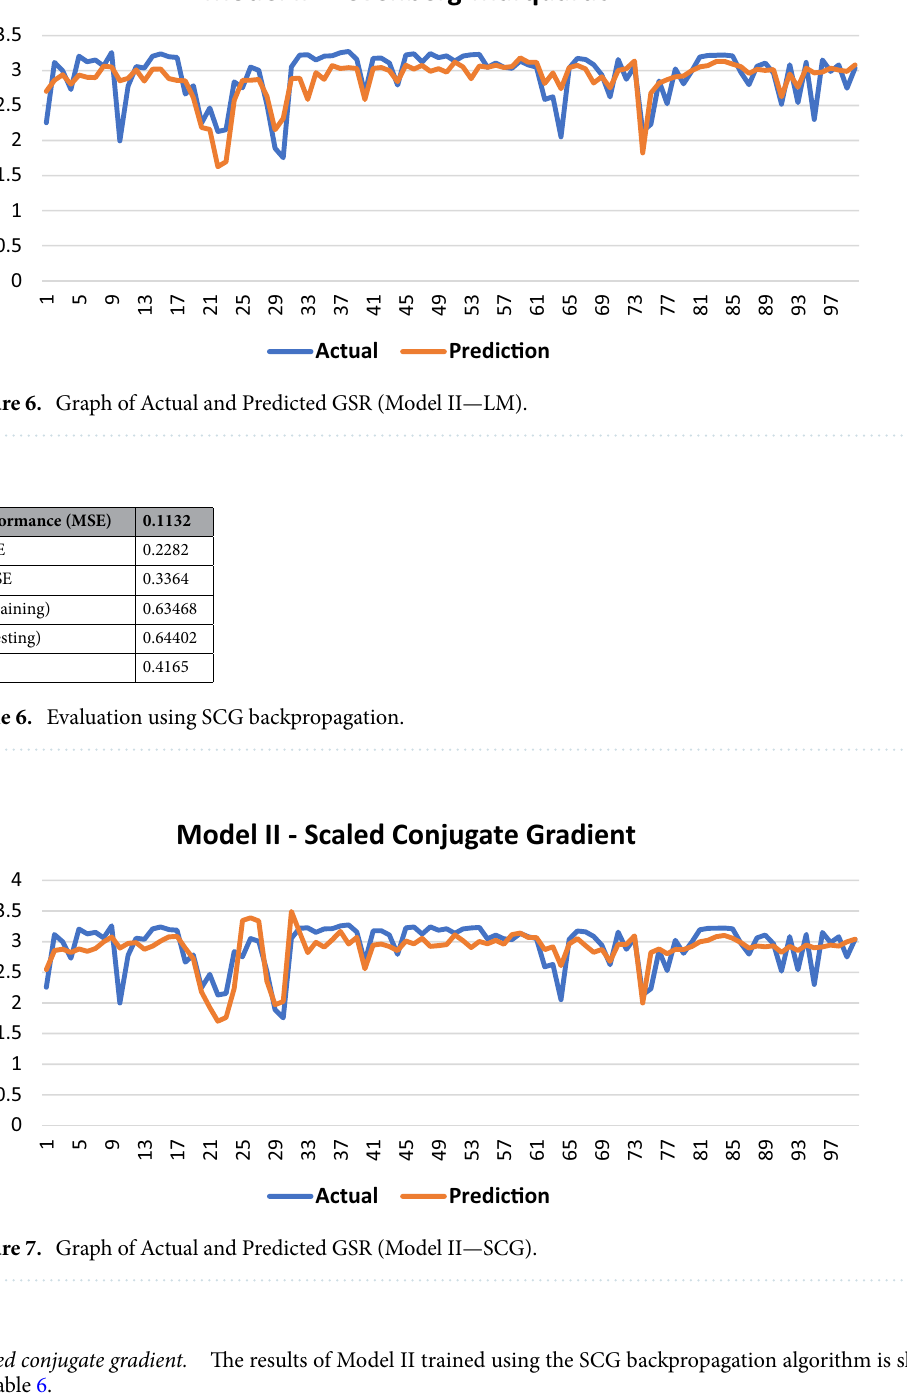
Scaled conjugate gradient. The results of Model II trained using the SCG backpropagation algorithm is shown in Table 6. 100 sets of actual and predicted GSR are randomly selected and plotted to aid in the visualization of the cor- relation between the actual values and the predicted values by the ANN model (Fig. 7). Bayesian regularization. The results of Model II trained using the BR backpropagation algorithm is shown in Table 7. 100 sets of actual and predicted GSR are randomly selected and plotted to aid in the visualization of the cor- relation between the actual values and the predicted values by the ANN model (Fig. 8). Model III (windspeed and relative humidity). In Model III, two input parameters are considered here: